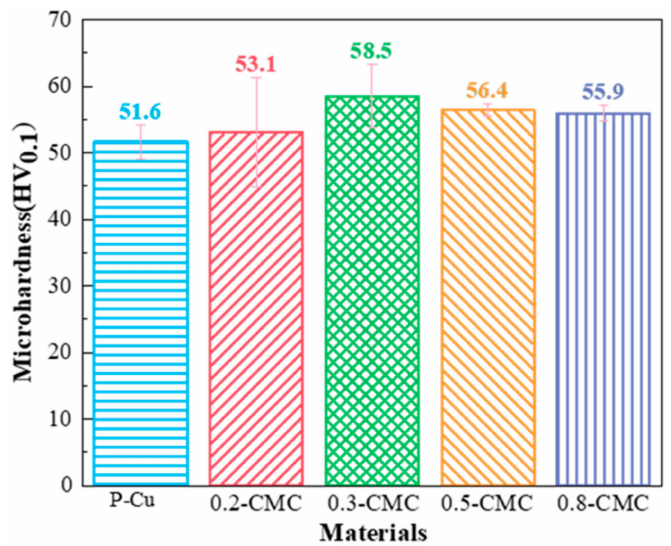
Figure 7. Microhardness of CMCs with different BNNS volume